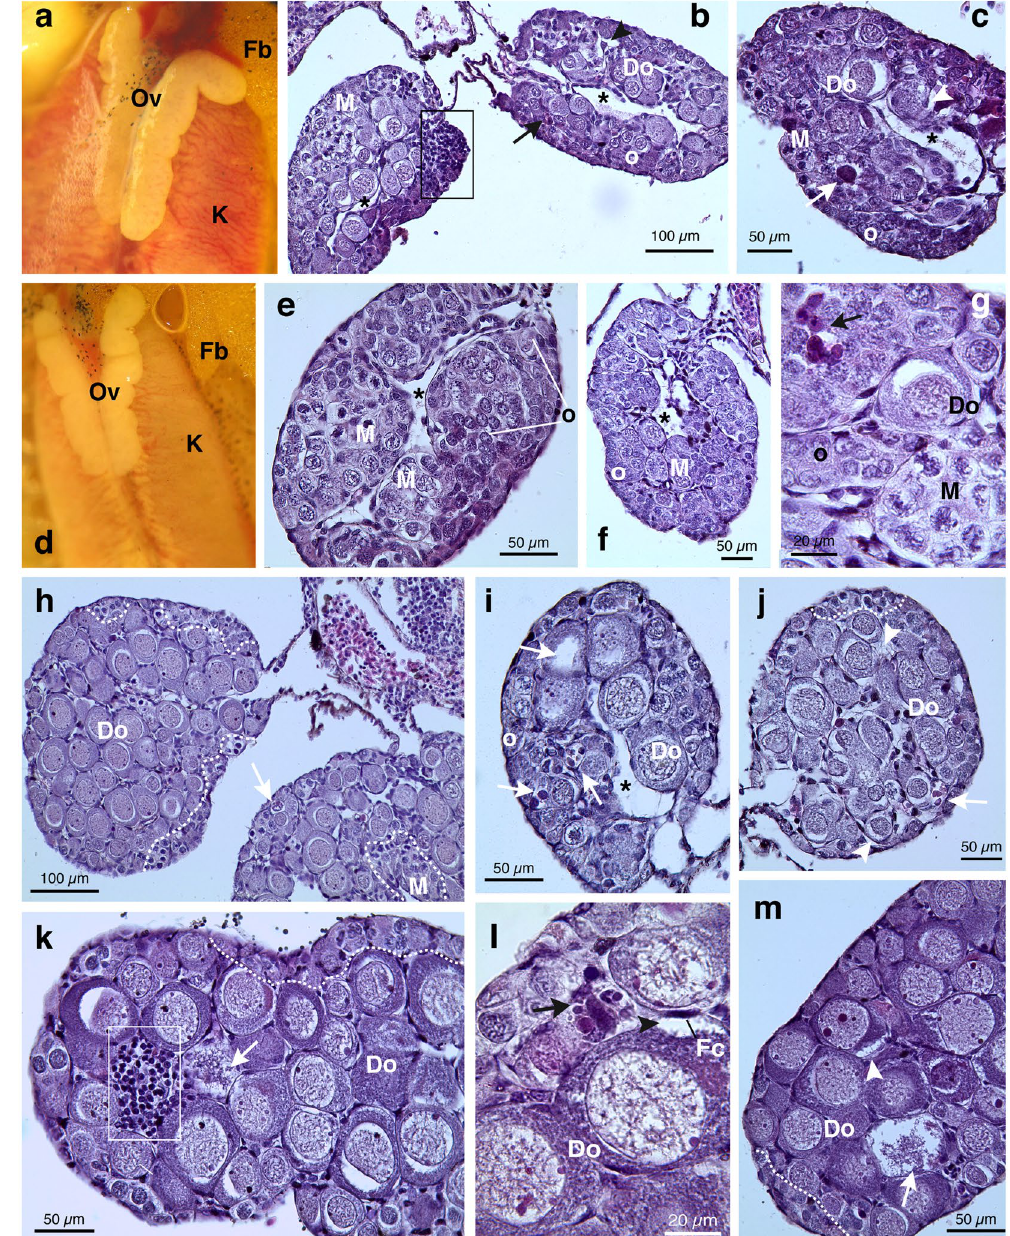
Figure 3. Representative photomicrographs and histological sections of phenotypic females of H . intermedia juveniles after exposure to pyrimethanil. Ovaries from animals exposed to 5 µ g/L ( a – c , f – h ) and 50 µ g/L ( d , i – m ). ( a , d ) Exposed animals maintaining a typical ovarian gross morphology. ( b , c , e – g , i ) Histological section of exposed animals showing a poorly developed ovarian structure; the cortex is filled with oogonia or early oocytes. Ovarian cavity lined by somatic cells is still distinguishable ( * ) ( h , j – m ) Ovaries at stage VIII or IX. The ovarian tissue is composed by growing previtellogenic diplotene oocytes; external patches of dividing oogonia and/or nests of leptotene-pachytene oocytes (marked by dotted lines) could be seen. ( b , c , h – m ) Diffuse degeneration phenomena affecting all germ cell types (arrows). ( b , c , j , l , m ) Note the enlargement of intercellular spaces and the detachment of diplotene oocytes from the follicular cell (arrowheads) and ( b , k ) mononuclear cells infiltration (marked by rectangle). ( g , l ) At higher magnification the presence of numerous apoptotic bodies frequently engulfed by macrophages is clearly detected (arrows). (Ov = ovaries; K = kidney, Fb = fat body; Do = diplotene oocytes; Fc = follicular cells; o = oogonia; M = meiocytes at leptotene-pachytene stages). All cross-sections are